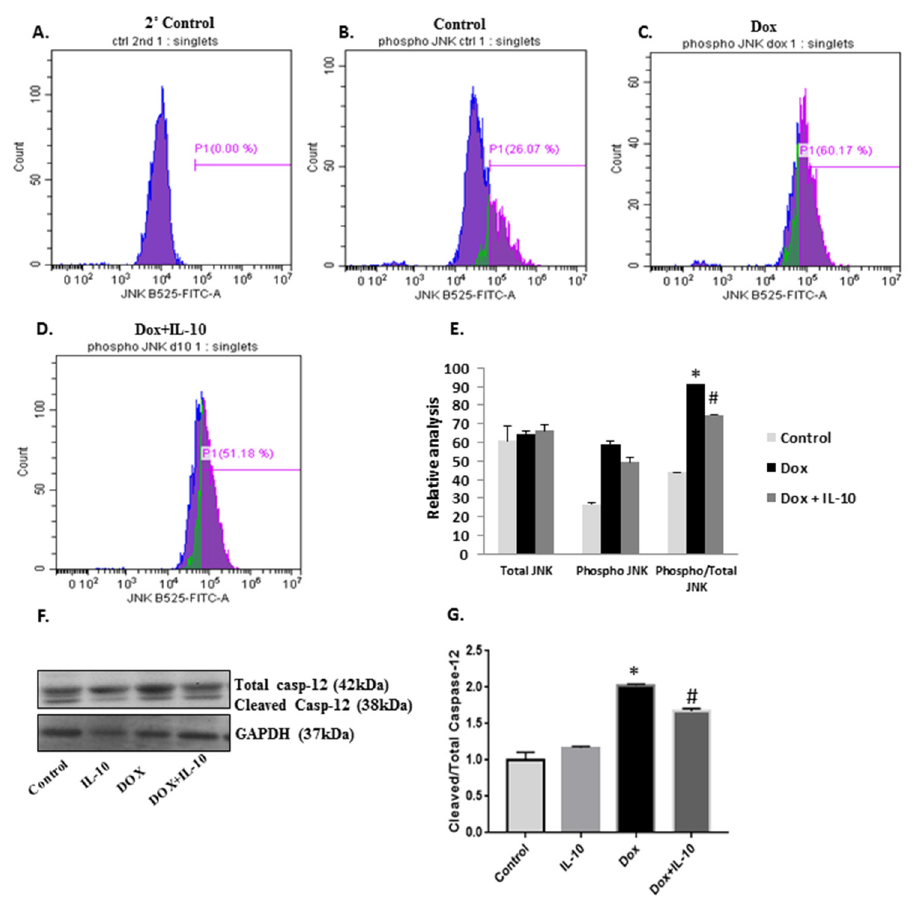
Figure 6. Effects of IL-10 on ER stress-induced apoptotic proteins. Expression of the ER stress-induced apoptotic proteins in isolated cardiomyocytes treated Dox (5.43 µg/mL) in the presence or absence of IL-10 (10 ng/mL) for 24 h. Flow cytometric analysis of treated cardiomyo- cytes; ( A ) secondary antibody control; ( B ) untreated control; ( C ) Dox; and ( D ) Dox + IL-10 of phospho- c-JUN NH2 kinase (JNK) using JNK antibody (1:100). ( E ) Relative analysis of total, phospho JNK, and phospho/total JNK in control, Dox, and Dox + IL-10 groups using flow cytome- try. ( F ) Western blot of total and cleaved caspase-12 using caspase-12 antibody (1:1000). GAPDH is shown as a loading control. ( G ) Densitometric analysis of cleaved caspase-12/total caspase-12. Data are means +/ − SE from 4 individual experiments. * p < 0.001 vs. control; # p < 0.005 vs. Dox.